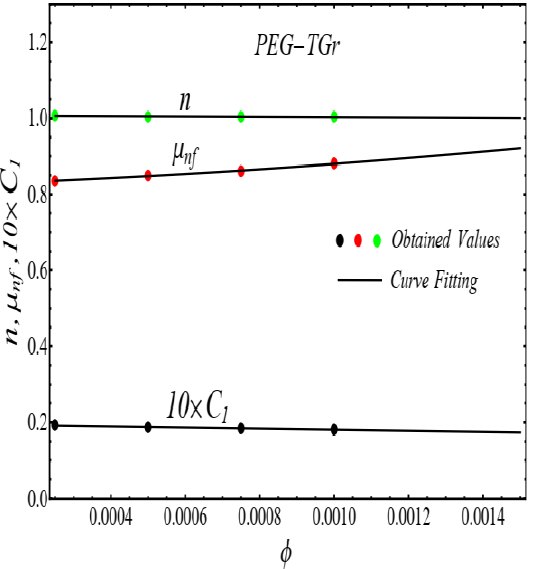
Figure 7. Curve fitting the Equation (3) for data in Table 1.